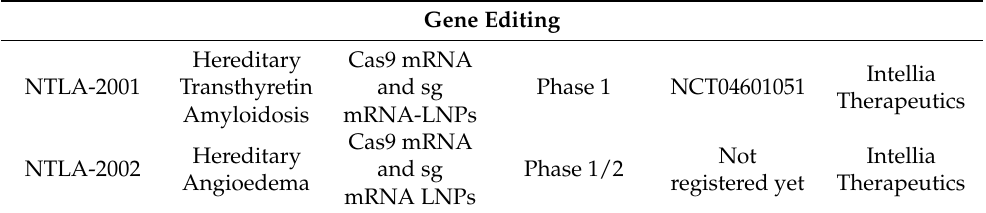
Table 4. mRNA Nanomedicines for Gene editing in Clinical Trials. A list of clinical trials for gene editing applications is provided in this table. Abbreviations: sg,